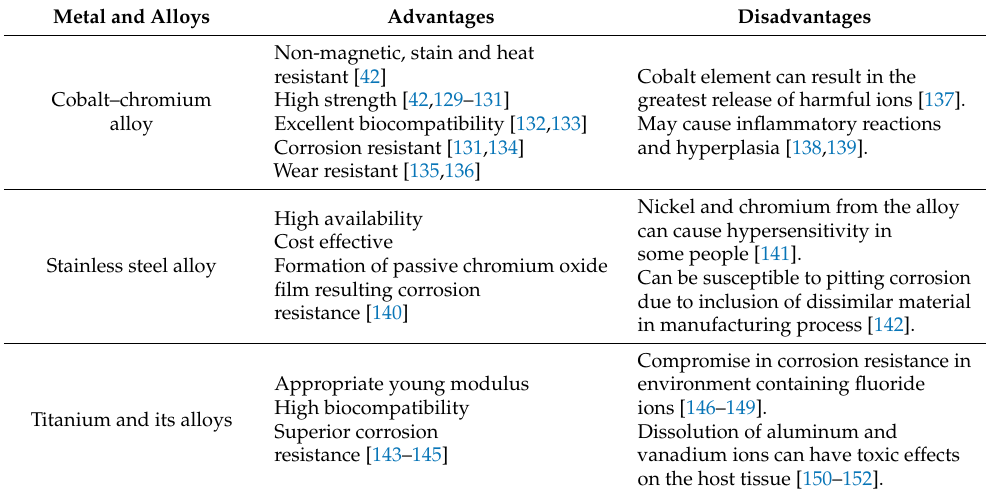
Table 3. Major advantages and disadvantages of most common implant materials used in dental prosthesis.